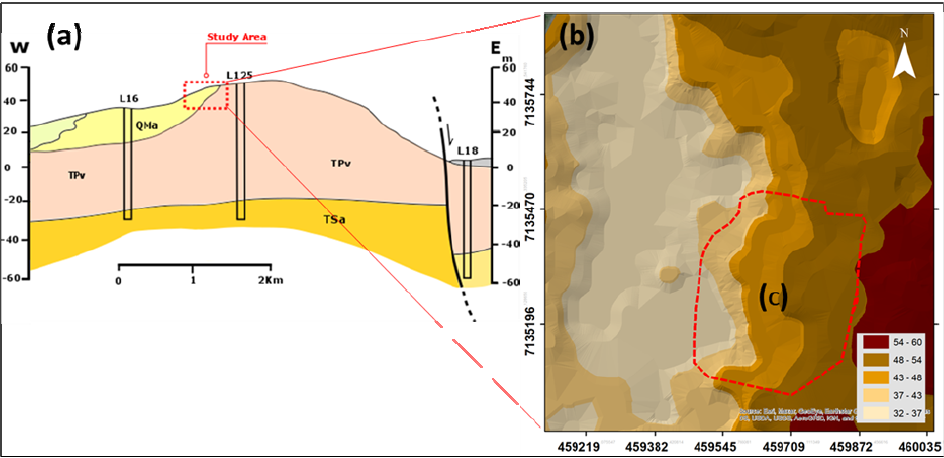
Figure 2. ( a ) Geological features; ( b ) study area topography; and ( c ) Hulene-B waste dump (adapt. Momade et al.